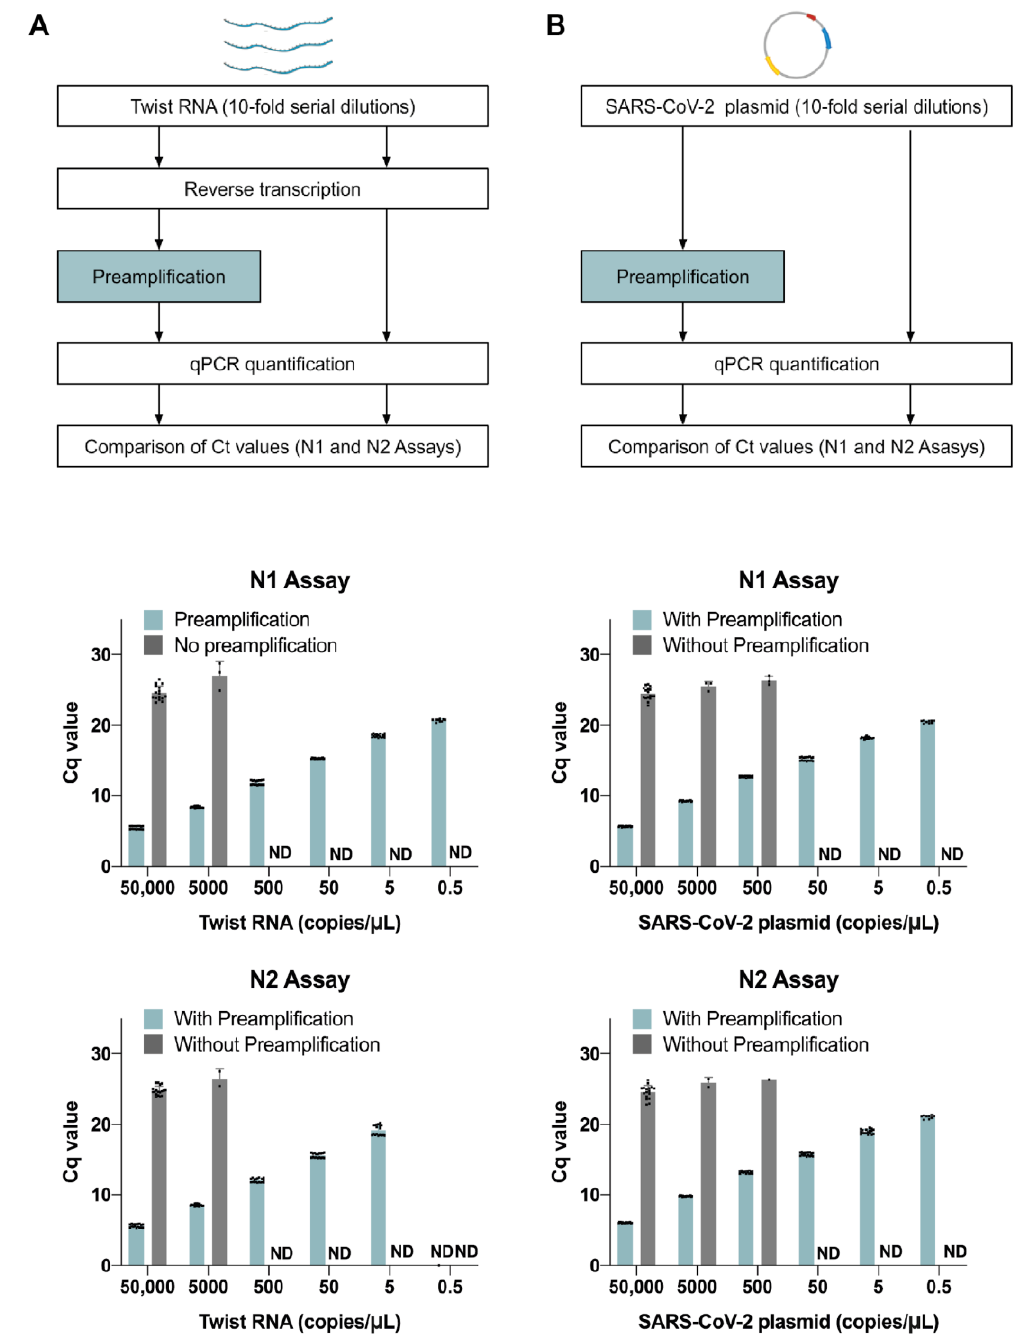
Figure 2. Preamplification leads to a lower limit of detection (LoD) in the microfluidic RT-qPCR method. Workflow for 10-fold serially diluted SARS-CoV-2 positive controls, with and without preamplification: ( A ) synthetic RNAs (Twist RNA) and ( B ) SARS-CoV-2 plasmid. Barplots show the Cq values with and without the preamplification step for both the N1 and N2 assays at each concentration. Data show the mean ± SD of valid Cq values from 18 replicates (2 biological replicates at each concentration, each with 9 technical replicates; each dot represents a technical replicate with a detected Cq value).